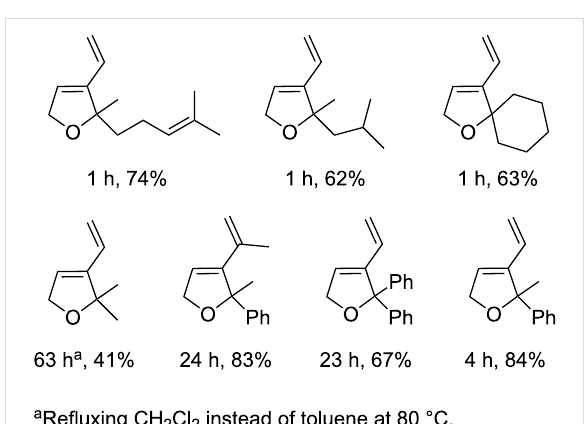
Figure 7: Dihydrofurans synthesised by photopromoted ene-yne RCM.